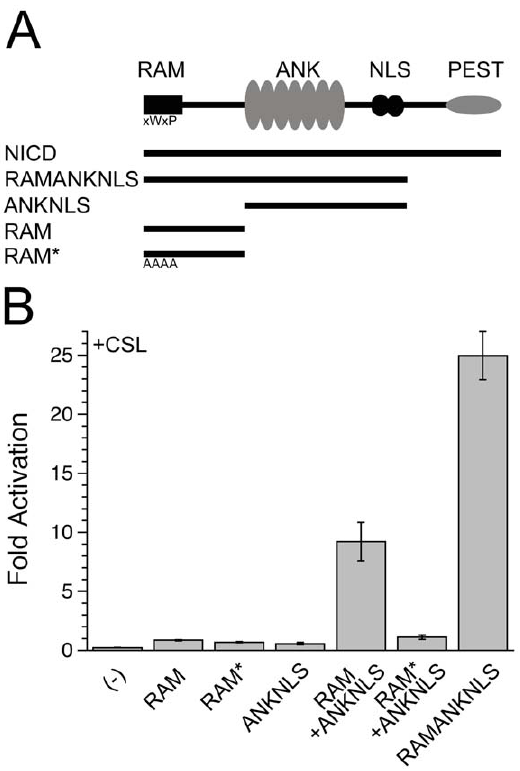
Figure 2. RAM and ANK are both required for transcriptional activation, and require covalent linkage for maximal activa- tion. A). A schematic of the regions comprising NICD, and the constructs used to dissect the function associated with each region. B). Notch-mediated transcriptional activation of NICD terminal truncations in OT11 cells, measured using a luciferase reporter downstream of multiple CSL-binding sites. Although very little activity is detected with RAM alone or ANKNLS alone, substantial activity is obtained when RAM and ANKNLS are co-transfected. Further activation is obtained when RAM and ANKNLS are connected in cis by their linker, consistent with an increase in the effective concentration. No activity is observed for the co-transfection of ANKNLS with RAM* (CSL-binding